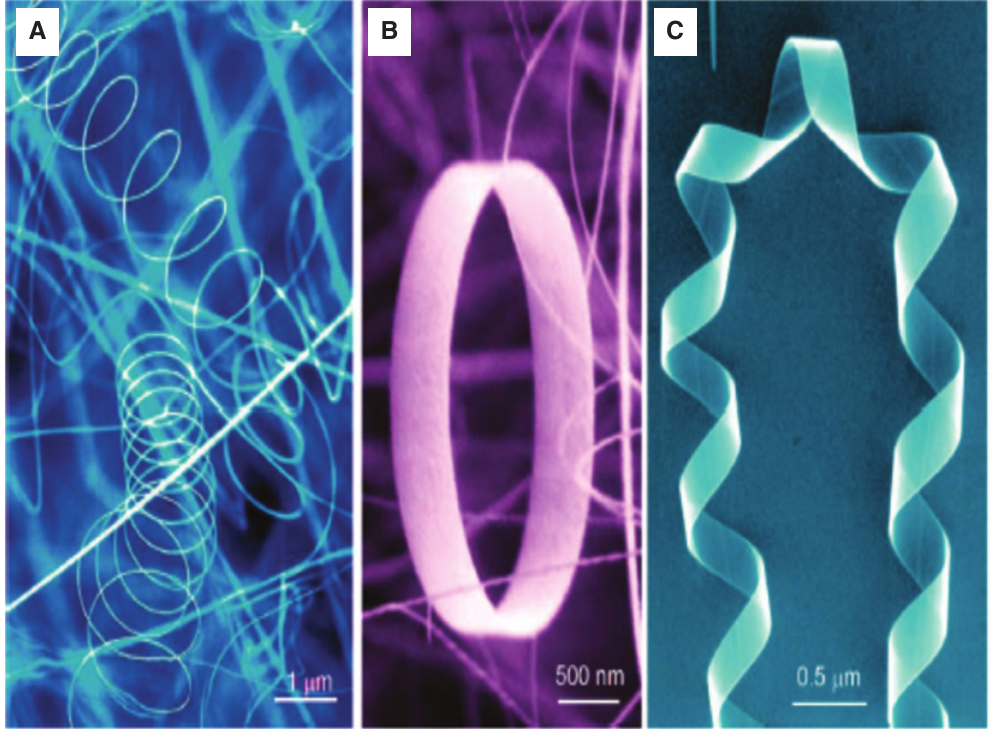
Figure 4: Examples of some ZnO nanostructures formed in nanofabrication process. (A) Nanobelt; (B) nanospring; (C) nanohelix (Reprinted with permission from Ref. [41], (A) copyright 2004 by Elsevier Ltd; (B) copyright 2004 by the American Association for the Advancement of Science; (C); copyright 2007 by Cambridge University